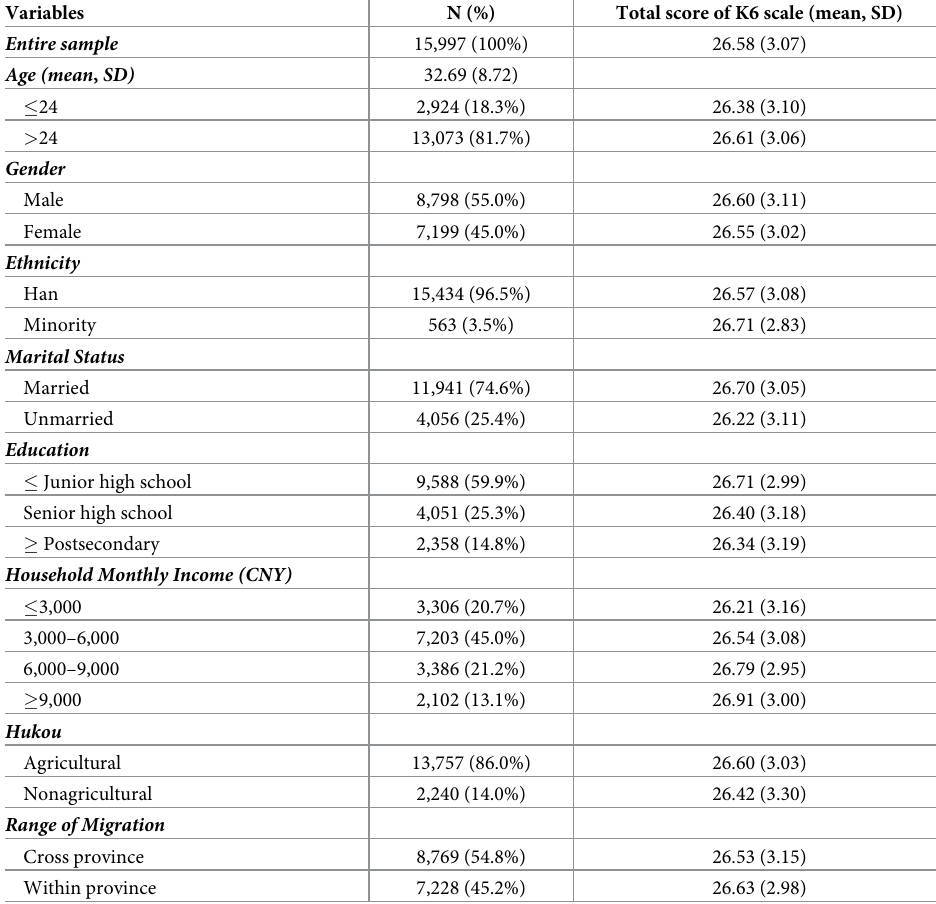
Table 1. Demographic characteristics and mental health status of the study sample (N = 15,997).